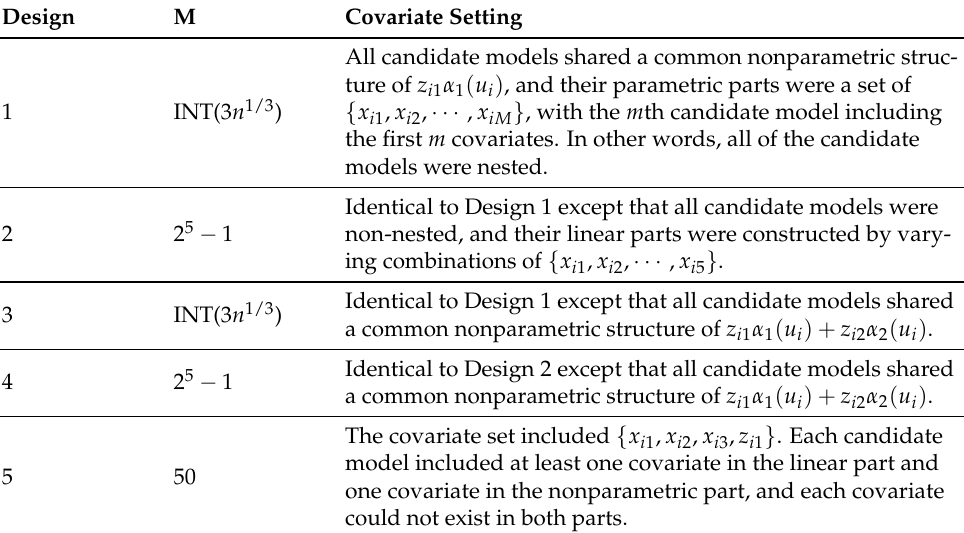
Table 1. Summary of designs in simulation